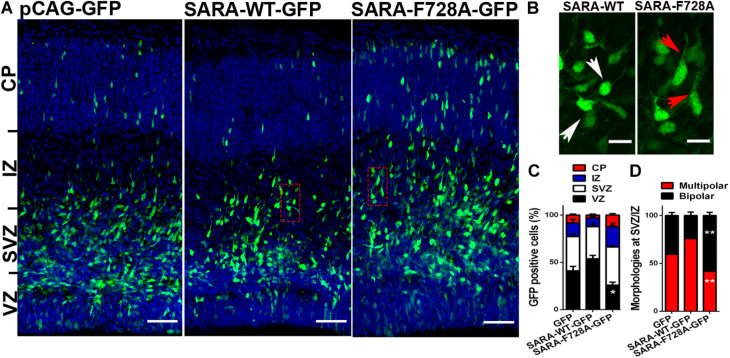
Over-activation of the TGFβ pathway by SARA-F728A-GFP ectopic expression alters both polarity acquisition and cortical migration of neurons in vivo. (A) Representative E18 coronal slices of brain cortices after in utero electroporation (IUE) of embryonic brains at E15, expressing pCAG-GFP, SARA-F728A-GFP, or SARA-WT-GFP and inmunostained for DAPI (blue). Three days after IUE (E18), brains were fixed and sectioned for confocal imaging. (B) Magnifications of insets shown in A (red squares). Neuronal morphologies and neurites developed during cortical migration are shown (red arrows: bipolar neurons; white arrows: multipolar neurons). (C) Quantification of GFP positive cells by layer (%). (D) Quantification of main morphologies detected in each condition at the boundary of SVZ/IZ. *p < 0.05 vs control, ANOVA, Dunnett’s post-test (1,500 neurons were analyzed by condition). Results represent the mean of three independent IUE experiments (n = 3). Scale bar: 50 μm.